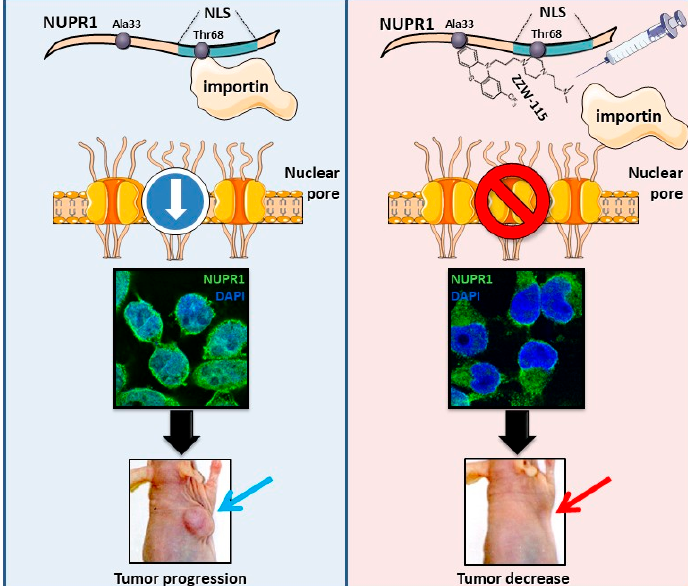
Figure 3. ZZW-115 hampered the nuclear translocation of NUPR1. (Left panel) NUPR1 is a nuclear protein with a predicted NLS. This part of the protein binds to importins and facilitates its translocation from the cytoplasm to the nucleus, through the nuclear pore complex. Thus, NUPR1 exhibits a nuclear localization (as showed in this immunofluorescence), where it can develop its activity and promote tumor progression. (Right panel) Nuclear magnetic resonance data indicated that ZZW-115 binds to NUPR1 in the residue Thr68 [35,37], located within the NLS. Thus, pharmacological inhibition of NUPR1 hampered the interaction with importin and its translocation to the nucleus (as showed in this immunofluorescence). After ZZW-115 treatment, NUPR1 was located in the perinuclear and cytoplasmic area, and inhibition of the nuclear activity of NUPR1 induced tumor growth arrest.